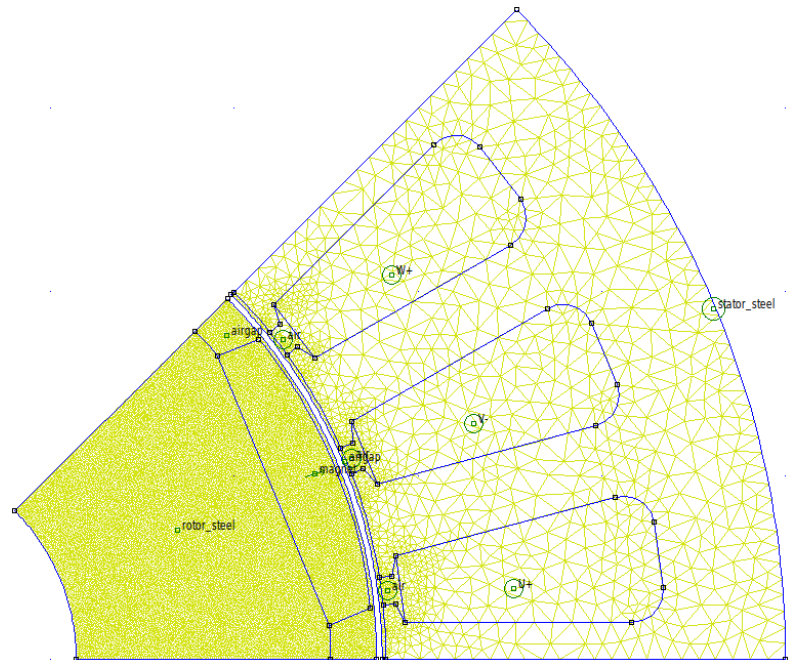
Figure 8. An example configuration for the mesh selectivity analysis. The mesh size is set to 0.18 mm on the rotor_steel, airgap, magnet